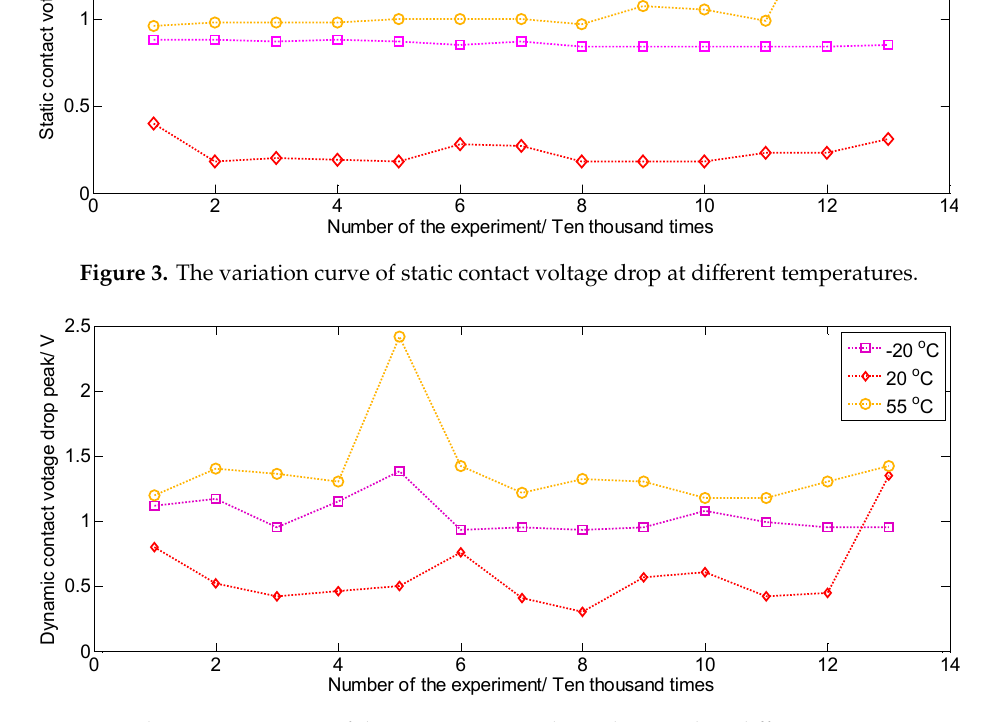
Figure 4. The variation curve of dynamic contact voltage drop peak at different temperatures.